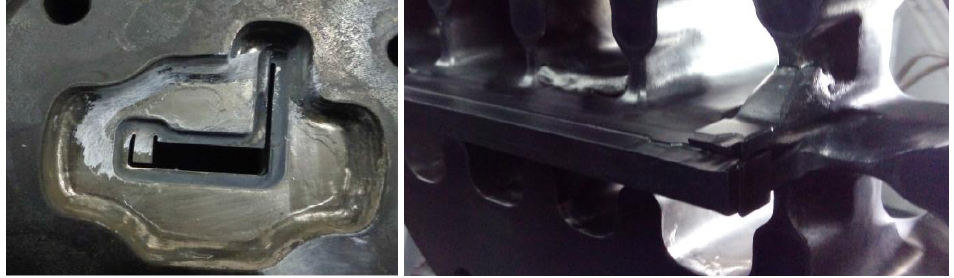
Figure 6. Peeling caused by hardness defect ( left ); correction error of excess chiseling ( right ). Table 1. Major types of die defects and their common sub-categories.